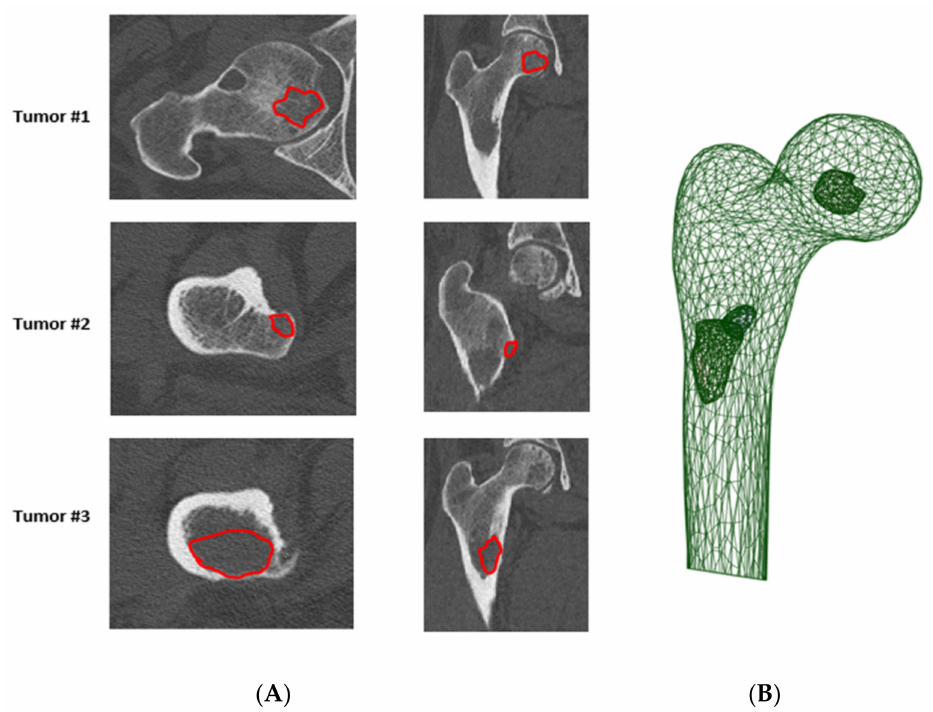
Figure 3. ( A ) Manual contour (in red) of a tumor, performed by a radiologist (annotator), ( B ) Patient- specific finite element model of proximal femur, with a specific representation of the